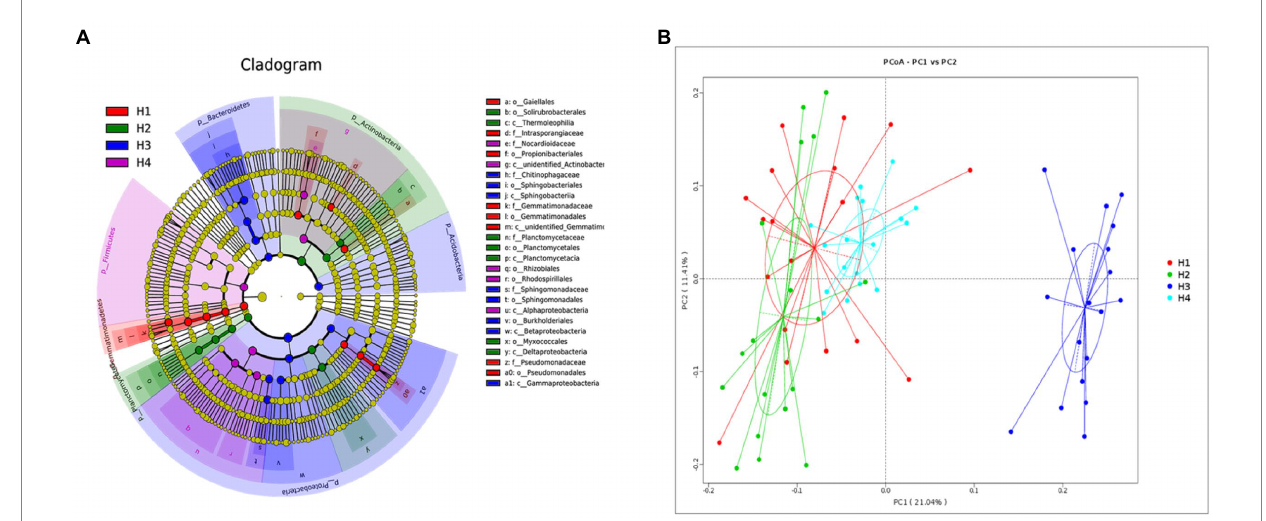
FIGURE 5 Evolutionary branch diagram of various soil bacterial species (A) and principal coordinate analysis (PCoA) of soil bacterial community structure (B) . H1–4, root growth stages of mixed forage: January 4 (H1), March 14 (H2), April 21 (H3), and May 19